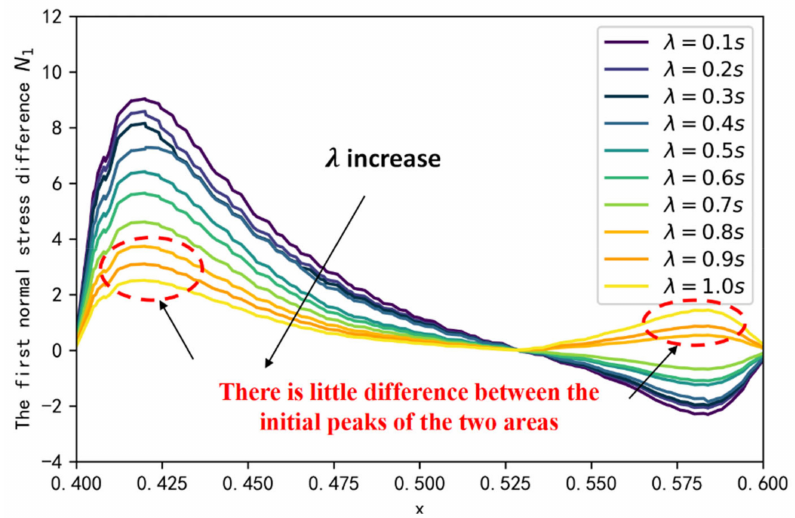
Figure 7. The first normal stress difference at the oil‑water interface in the dead end.